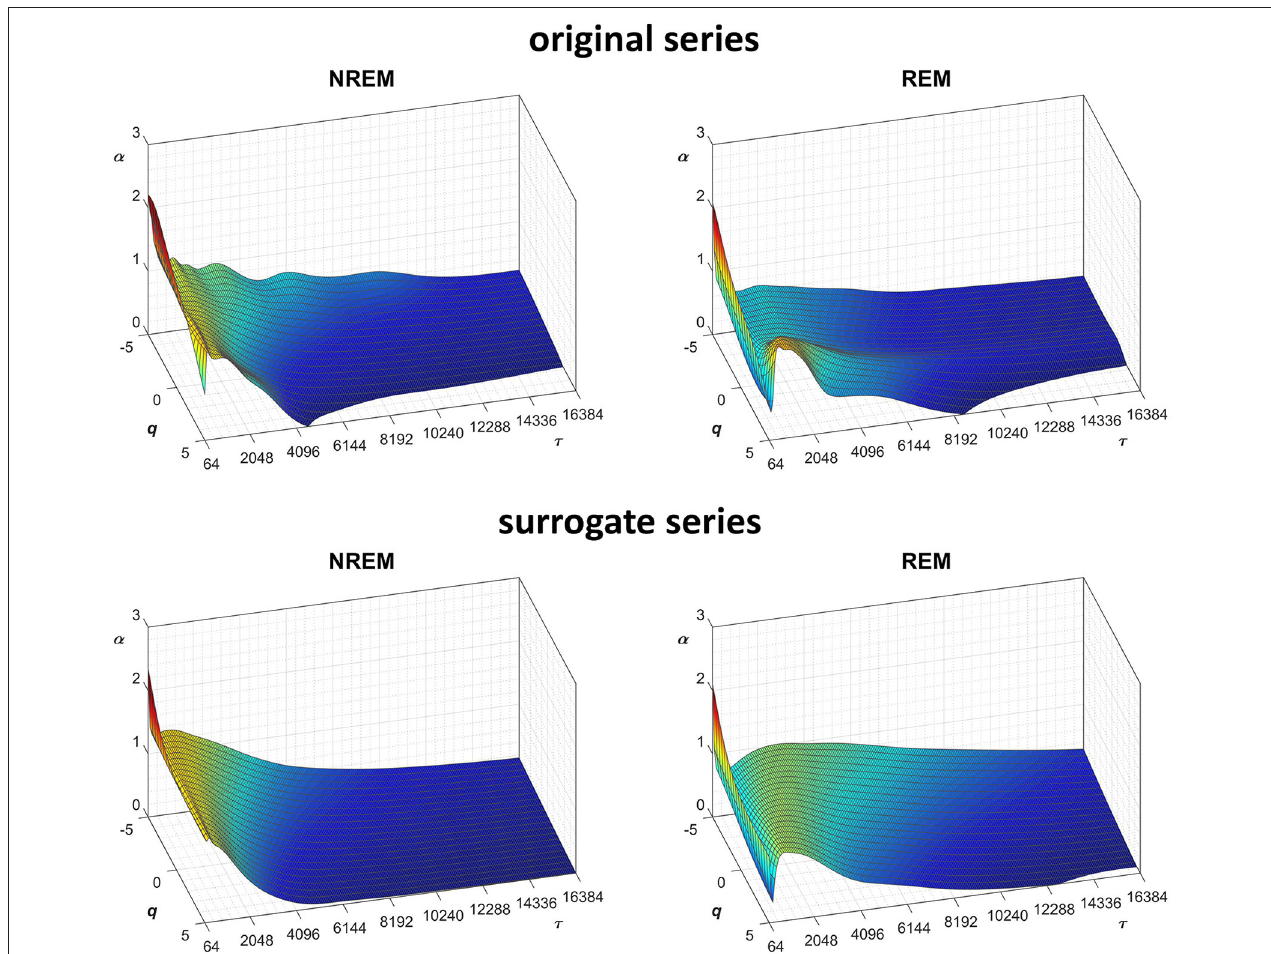
FIGURE 12 | Scale coefficients during NREM and REM sleep. Coefficients calculated by Equations (22), combining DFA 1 and DFA 2 estimates by Equations (23), for original (Left) and Fourier-phase shuffled surrogate series (Right) . The scale τ , in milliseconds, is the box size n multiplied by the sampling period.